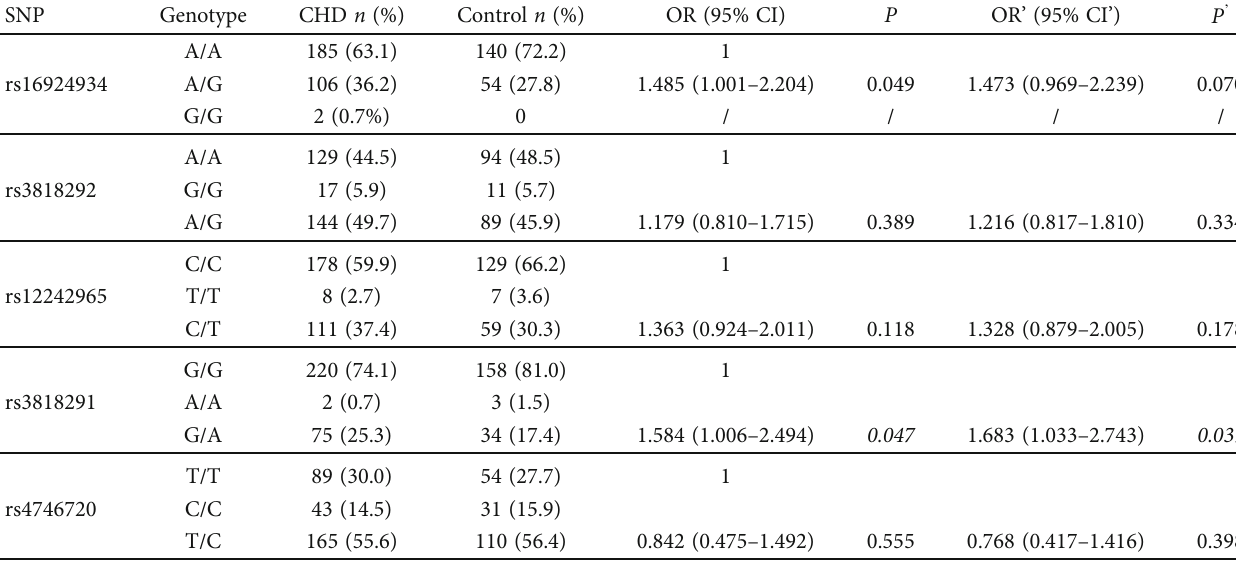
Table 3: Additive inheritance model of genotype distribution between CHD and control groups.